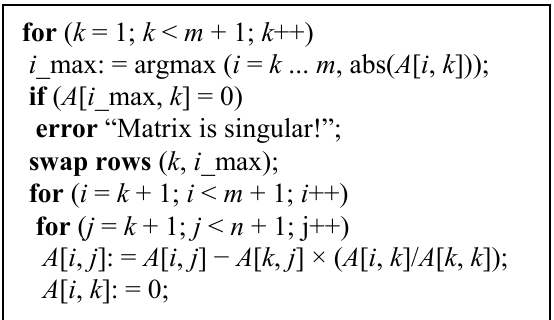
Figure 3. The pseudo-code of the Gaussian elimination algorithm used in